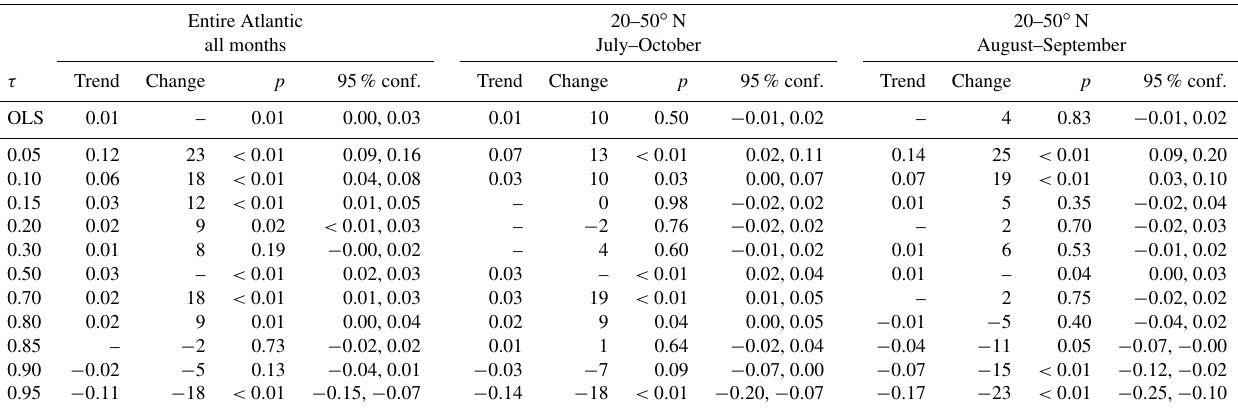
Table 3. Quantile trends of tangential acceleration over 1966–2019 (kmh − 1 d − 1 yr − 1 ) for months and regions labeled below. Trends of magnitude below 0.01 are not reported.